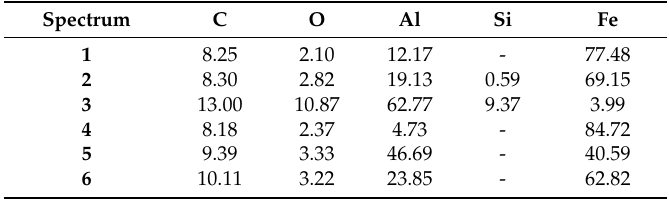
Table 5. Elemental composition mapping (normalized mass concentration